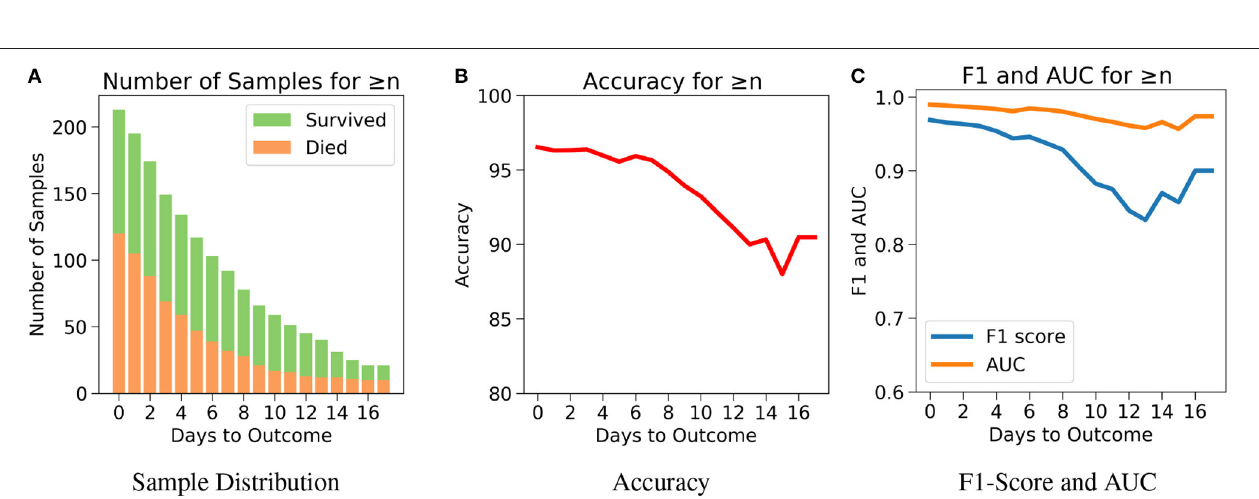
FIGURE 6 | The performance of neural net on the test data using case 2: Number of days to outcome greater than or equal to n . (A) The class-wise distribution of the cumulated data-points ( ≤ nth day) for all samples in the imputed test set. (B) Accuracy of the model evaluated for different days to outcome. (C) F1-score and AUC of the model evaluated for different days to